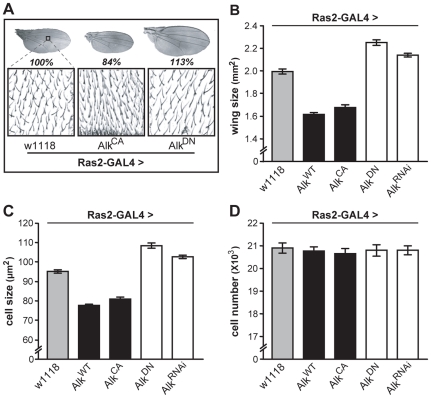
dAlk activity in Ras2-expressing cells affects organism size through changes in cell size and not cell number.(A) Representative pictures of wings isolated from female flies of the indicated genotype. The magnified areas show wing hairs, arising from single wing-blade intervein cells located between veins 3 and 4 on the dorsal wing blade, up to the posterior cross vein. (B) Measurements of wing surface areas shows significant differences in total wing size for each genotype (ANOVA F(4,65)  = 197.74, p<0.0001, n≥12). Calculated cell size (C) and total number (D) of intervein cells reveal changes in adult wing size correspond to significant changes in cell size (ANOVA F(4,65)  = 186.32, p<0.0001, n≥12) and not cell number (F(4,65)  = 0.14, p>0.96, n≥12). Error bars denote S.E.M.